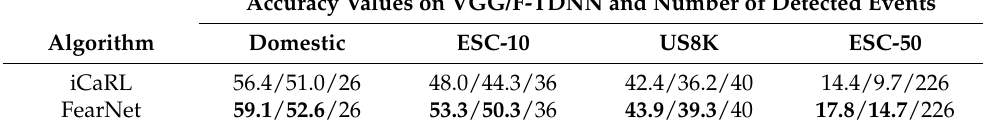
Table 6. The average accuracy values of the ICL algorithms with GMM using VGG/F-TDNN features and number of detected classes in three